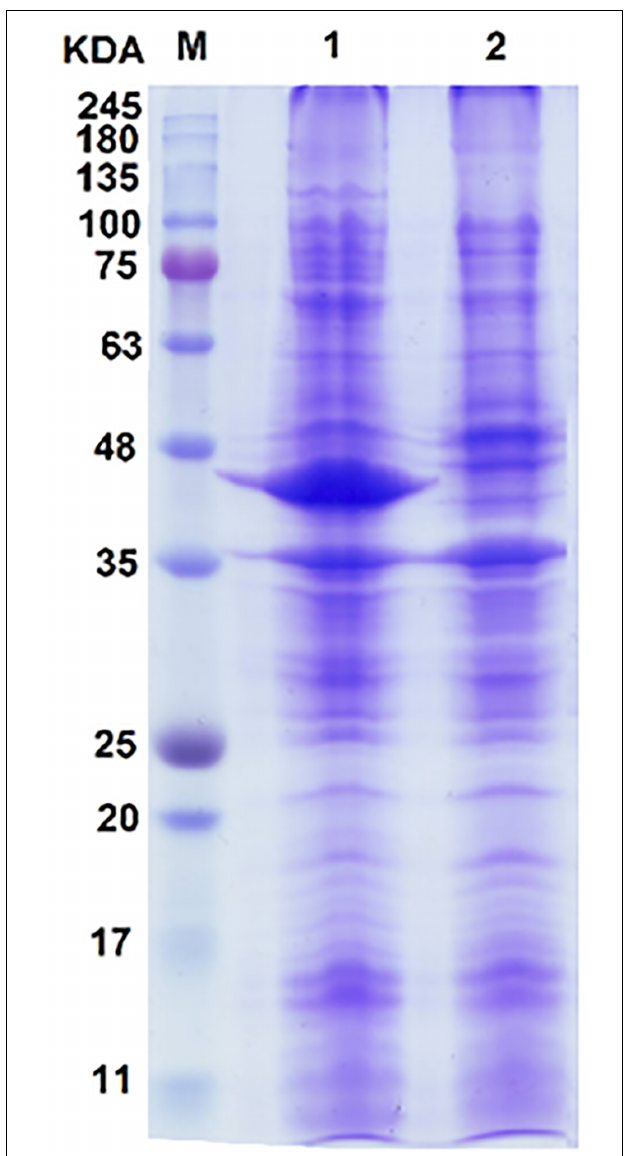
FIGURE 2 | SDS–PAGE analysis of proteins resulting from the expression of the dsz gene cluster in E. coli BL21 host. Lane 1, induced recombinant cell; lane 2, negative control of E. coli BL21 carrying pCom8 without dsz genes; lane M, protein size marker. A diffused protein band with the size between 42 and 45 kDa is observed. This makes its accurate assignment rather difficult. Because of close protein sizes of DszA (45.1 kDa) and DszC (42.2 kDa), they are often observed with overlap. No protein band was observed on SDS–PAGE that can be referred to DszB with 38.9 kDa protein size (see text for possible